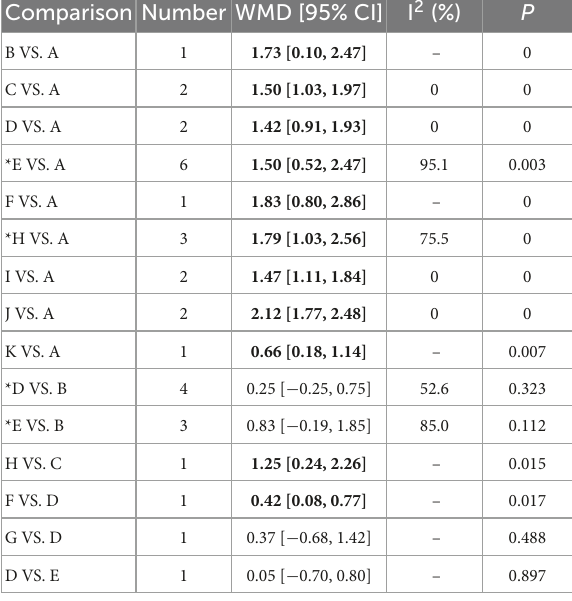
TABLE 3 Visual analog scale (VAS) pairwise meta-analysis